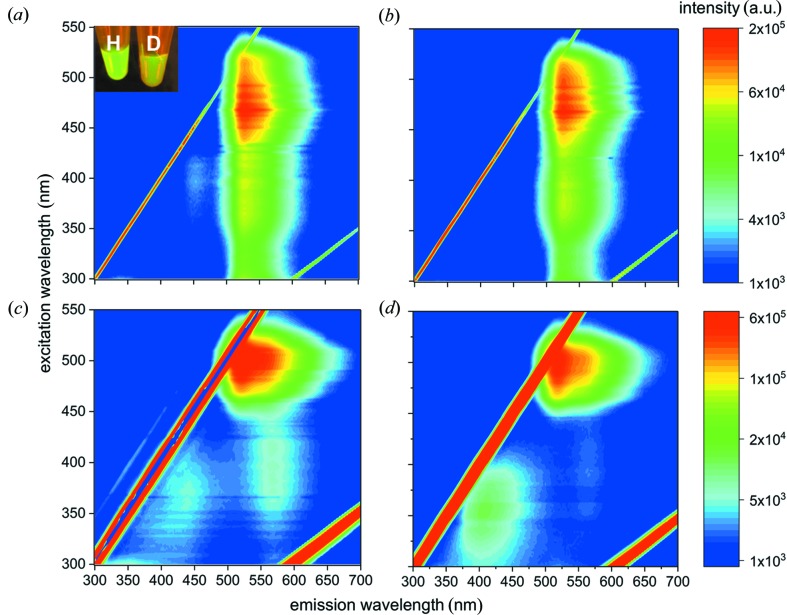
Fluorescence mapping of Tetdron. Solution measurements of (a) hydrogenated and (b) deuterated Tetdron. Crystal measurements of (c) hydrogenated and (d) deuterated Tetdron.